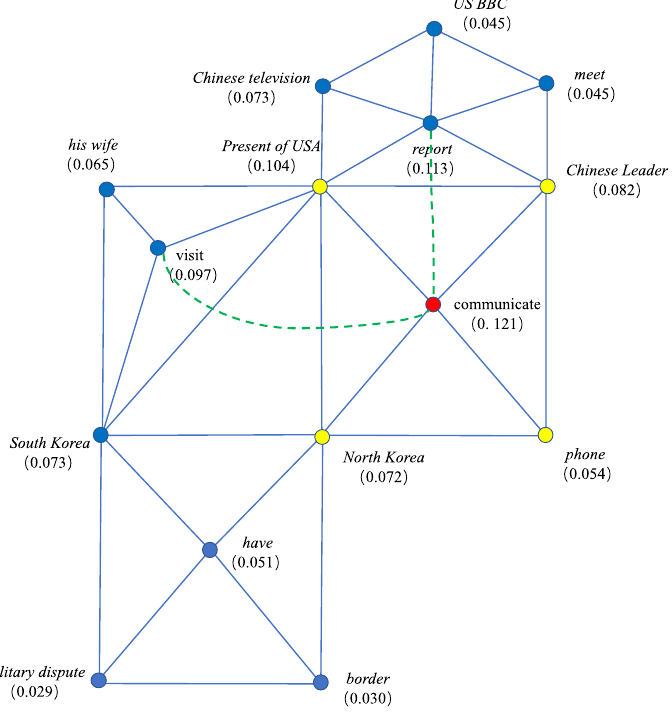
Figure 4. The event connection graph by linking semantically similar triggers.